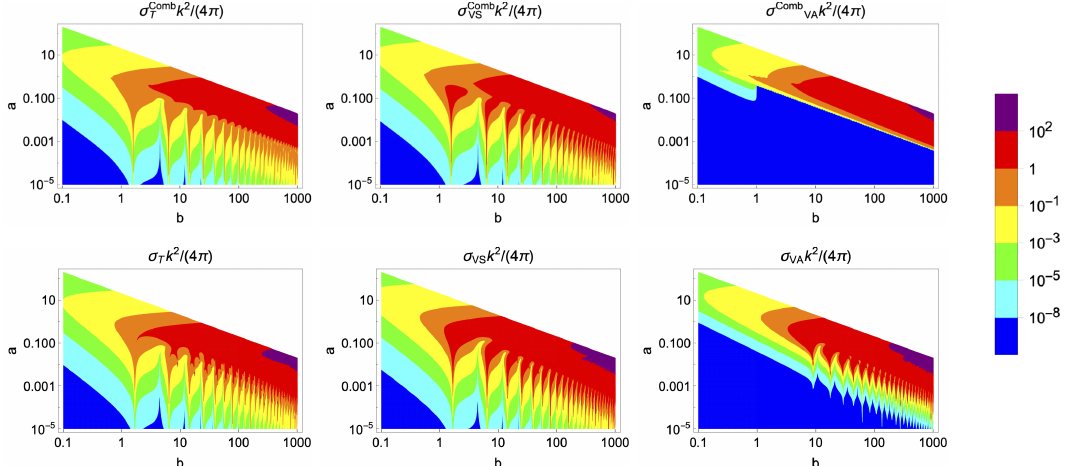
( × k 2 / (4 π ) ) on the a - b plane, calcu- VA